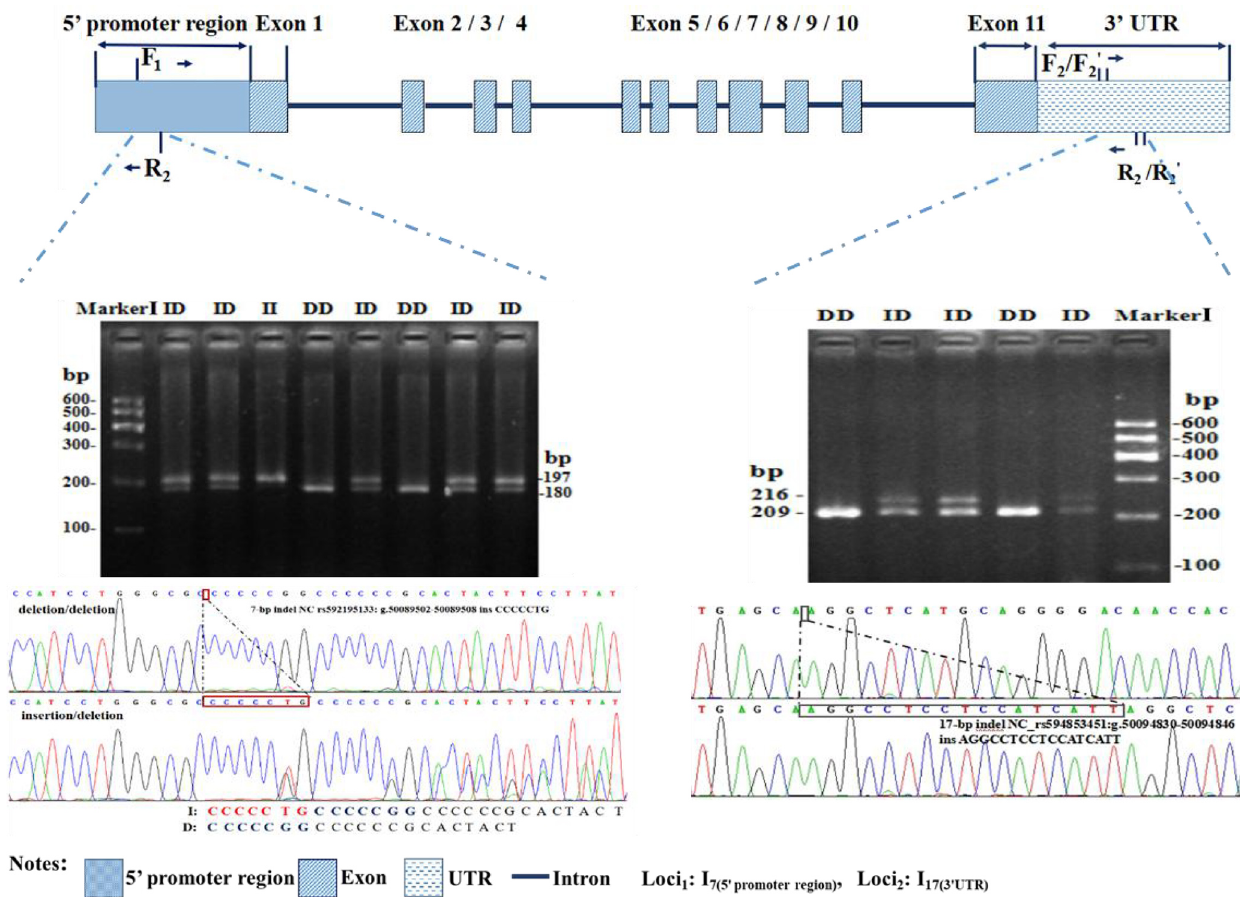
Figure 1. Electrophoresis diagram and sequence of 3 (cid:48) UTR-insertion-17bp loci and 5 (cid:48) promoter region-insertion-7bp within the ovine SIRT7